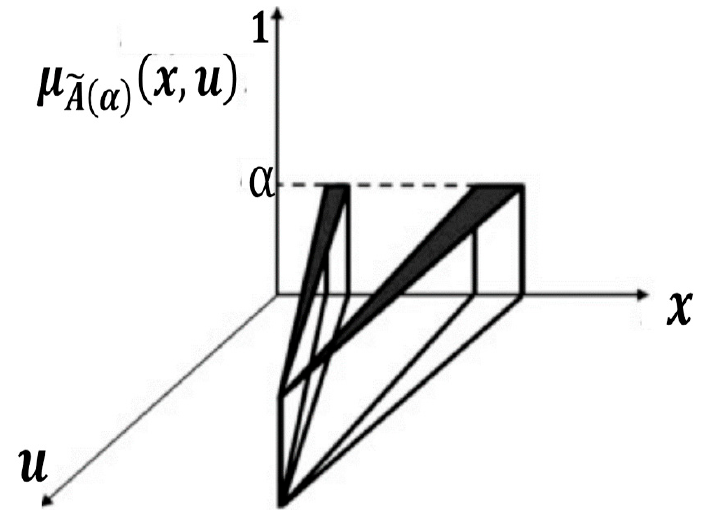
Figure 5. Representation of an alpha-plane corresponding to a type-2 fuzzy set.